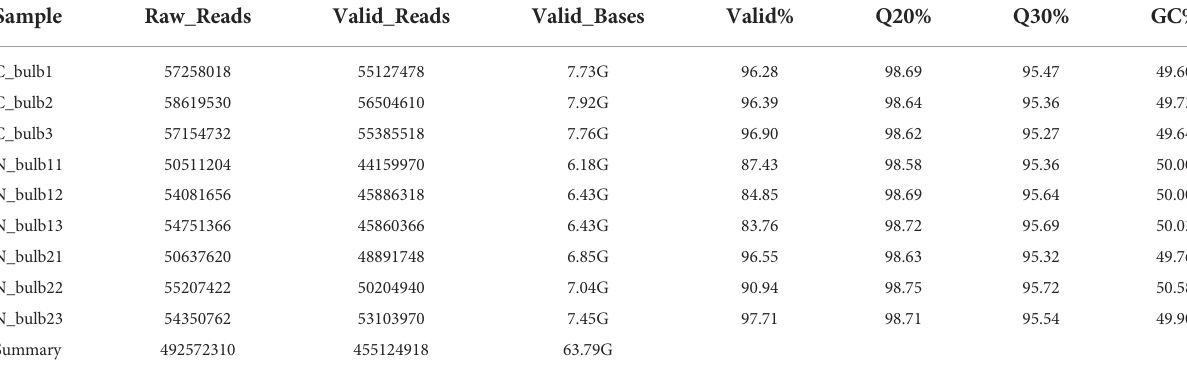
TABLE 2 Summary of the sequences analyzed for L. pumilum bulb samples.